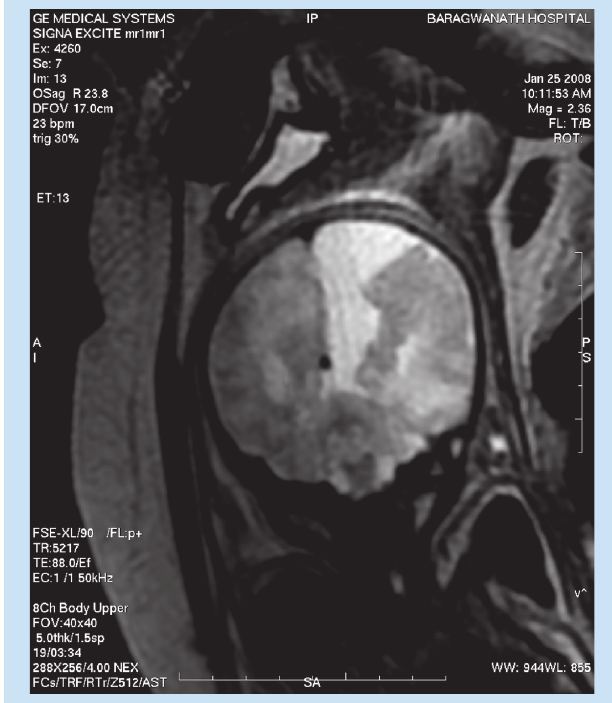
Fig. 2. Coronal T2W image demonstrating CSF-filled cleft lined by grey matter with abnormally radiating gyri.